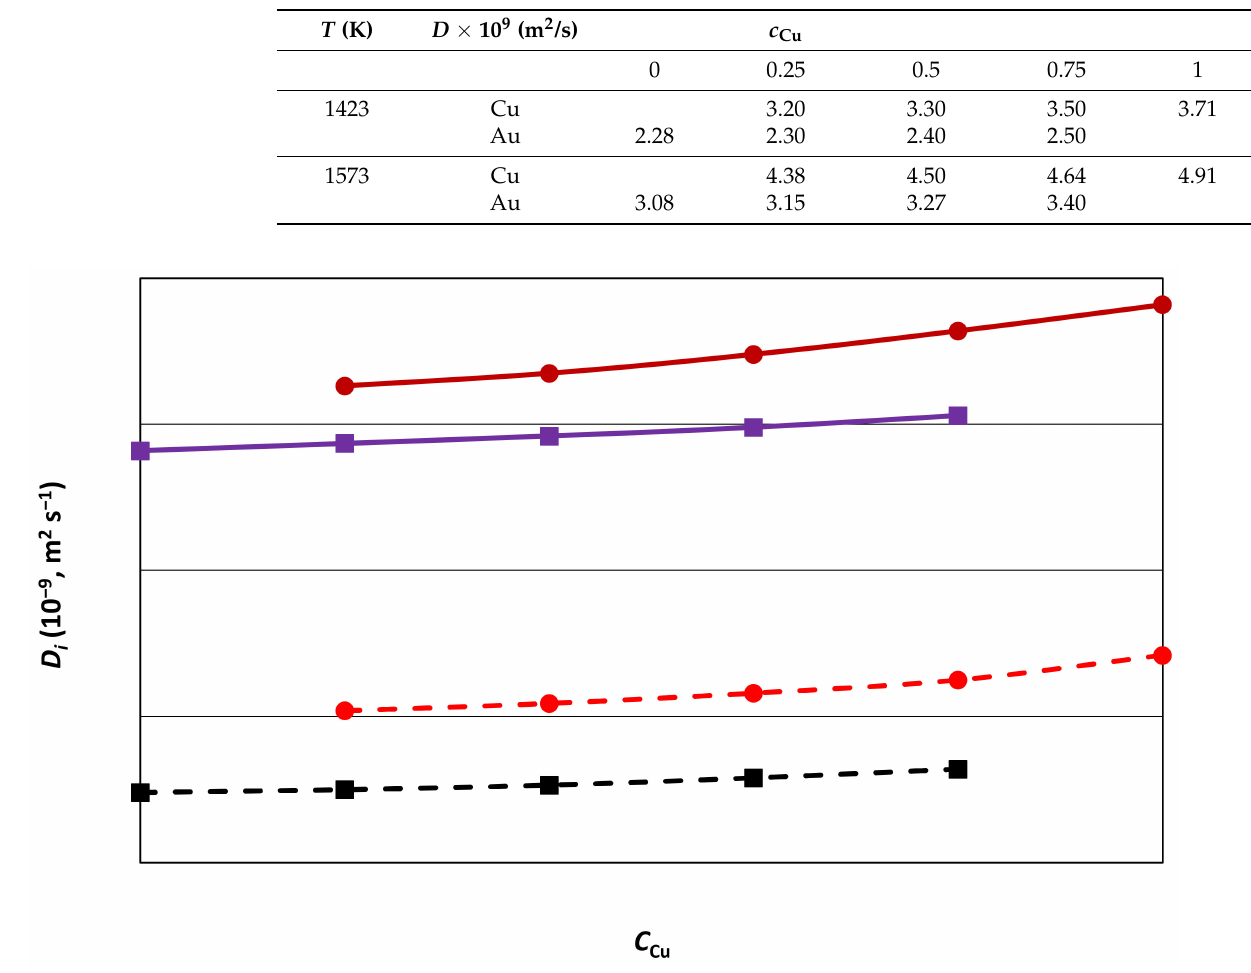
Figure 1. Self-diffusion coefficients of Cu (circles) and Ag (squares) in liquid Cu-Ag alloy at T = 1423 K (dashed line) and T = 1573 K (solid